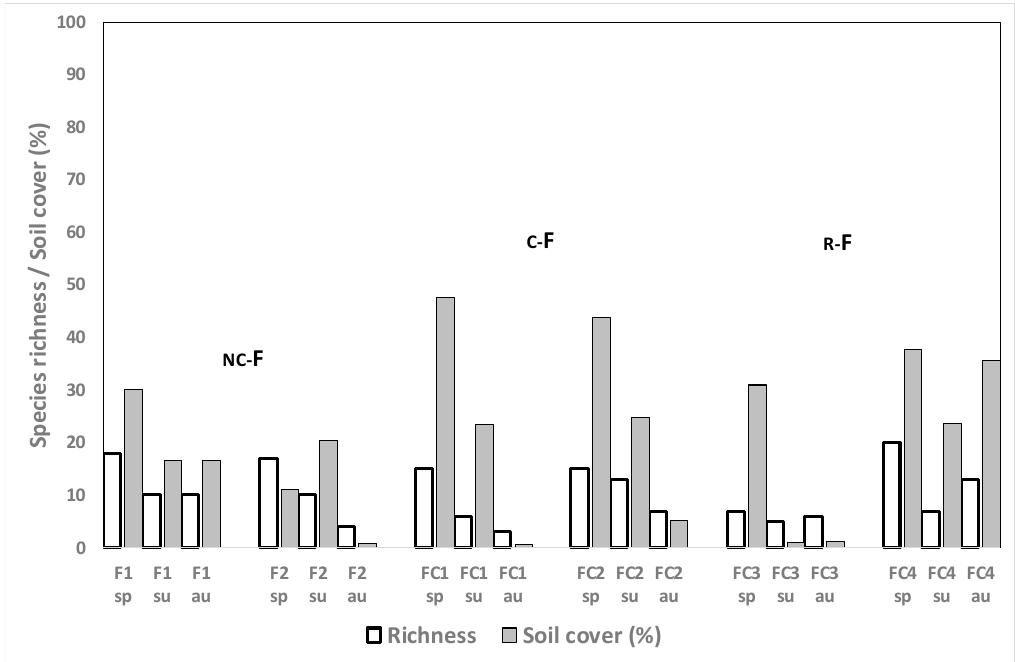
Figure 5. Weed species richness and total weed soil cover (%) for the fescue fields in their first year of establishment in spring (sp), summer (sum) and autumn (au) 2014 in different crop rotation sequences. The letters show the crops from 2013 until the sampling moment, the sampled crop being the last of the rotation (in larger letters). R: rice, Nc : no crop, C : cereal, F: fescue.